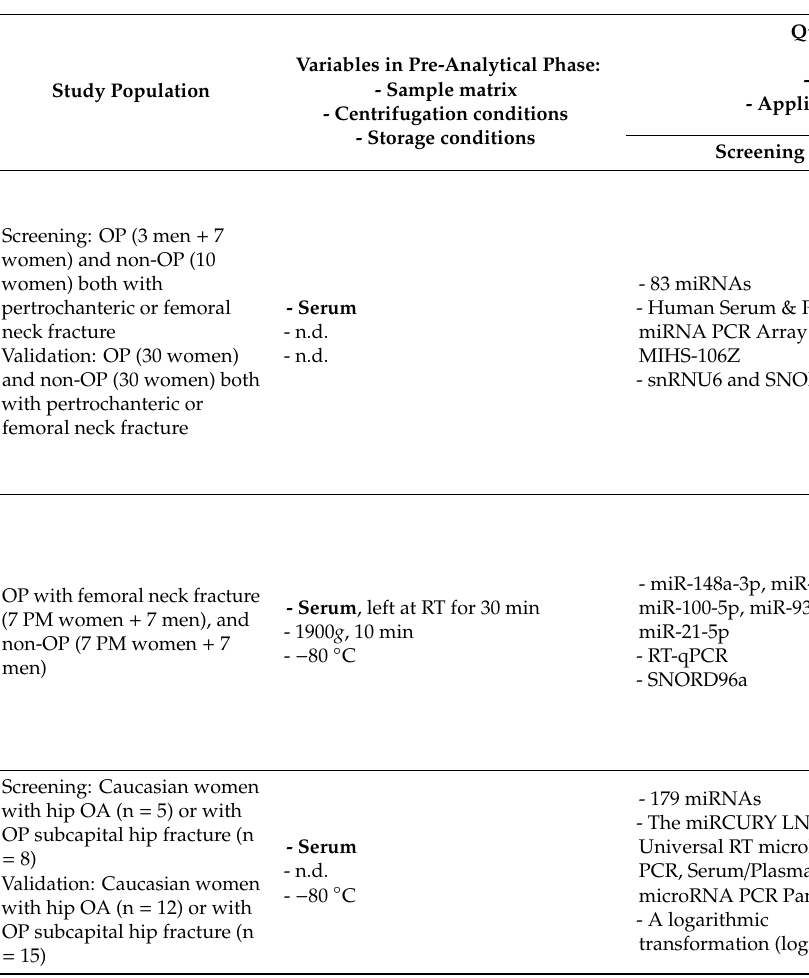
Table 2. Circulating miRNAs in OP